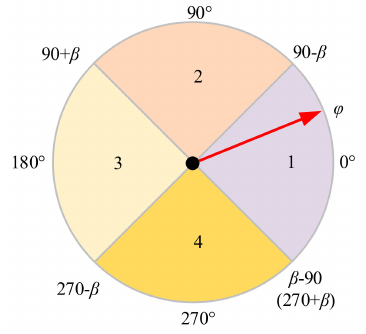
Figure 6. Operating regions of the DAB WPT system without dead time.